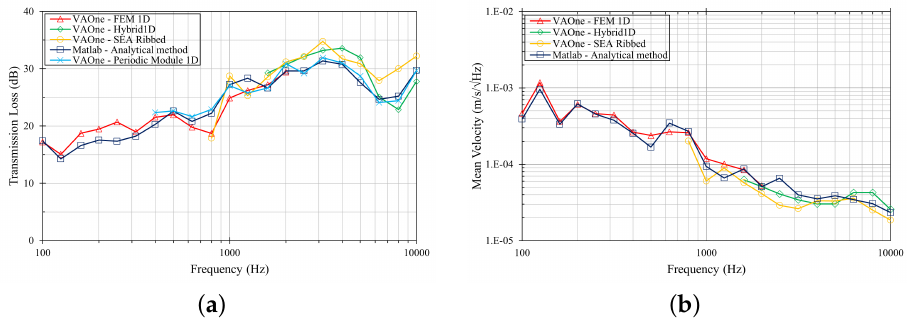
Figure 19. Vibro-acoustic responses of a panel with Hat stiffeners (1D stringers): ( a ) sound transmis- sion loss and ( b ) space-average mean vibration velocity.